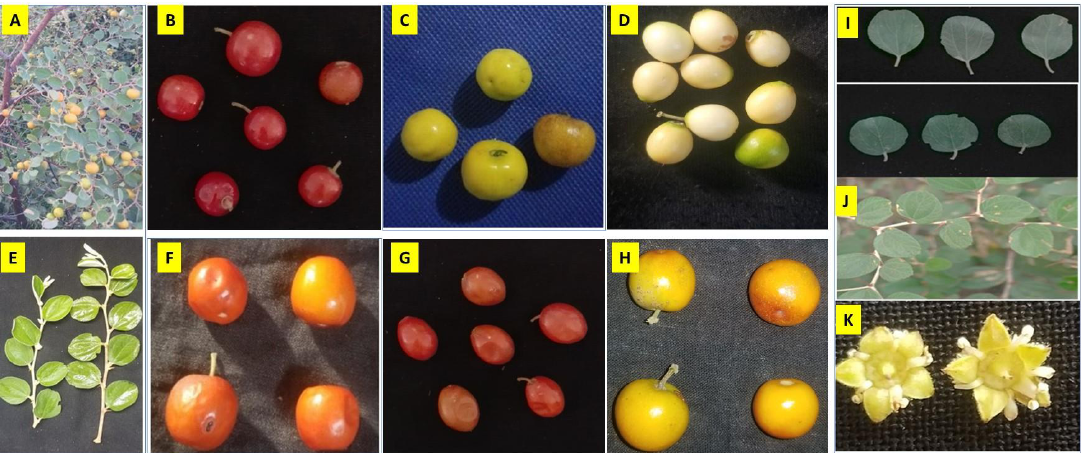
Figure 3. Photographs of collected Z. nummularia fruits and leaves from Malakand Division, KP, Pakistan ( A – H ) designated diversity in fruits shape/size and color and ( E,I,J ) designated leaf diversity and ( K ) for flowers of Z. nummularia .